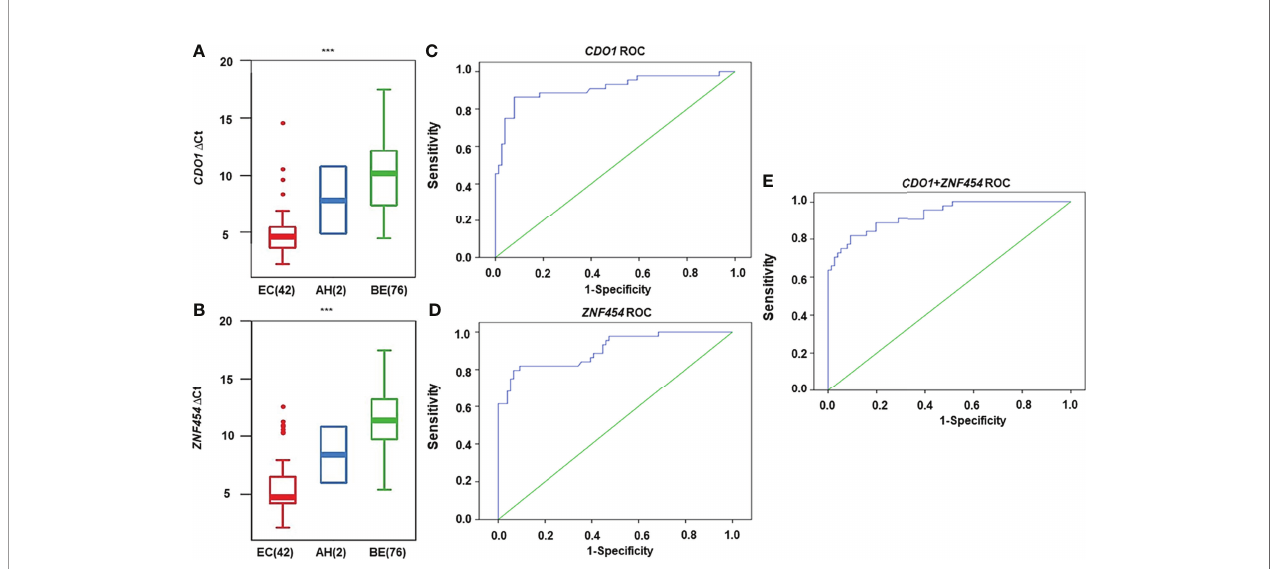
FIGURE 4 | DNA methylation levels for candidate genes detected by quantitative methylation-speci fi c polymerase chain reaction (qMSP) in cytological specimens. DNA methylation levels are displayed as the difference in cycle threshold ( D Ct) – values for (A) CDO1 and (B) ZNF454 . Horizontal bars in the middle indicate the average methylation levels. The area under the receiver operating characteristic curve (AUC-ROC) for the DNA methylation status of (C) CDO1 , (D) ZNF454 , and (E) combination of the two genes. *** P <